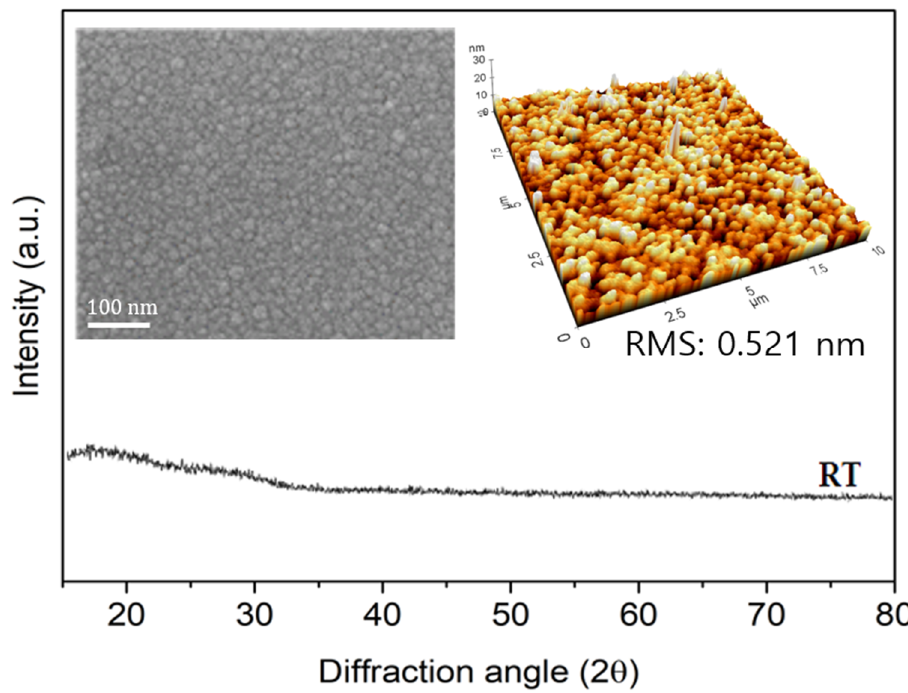
Figure 2. X-ray diffraction patterns of IZTO films with room temperature deposition on a parylene substrate. Insets are SEM image (left) and surface roughness (right) of IZTO film, respectively. The fabrication process of the UFOPVs—with the structure of IZTO/PEDOT:PSS (with pattern (p-PEDOT) and without (f-PEDOT), 40 nm)/PTB7:PC 7 1BM (with pattern (p-Al) and without (f-Al), 100 nm)/Ca (20 nm)/Al electrode (100 nm)—is shown in Figure